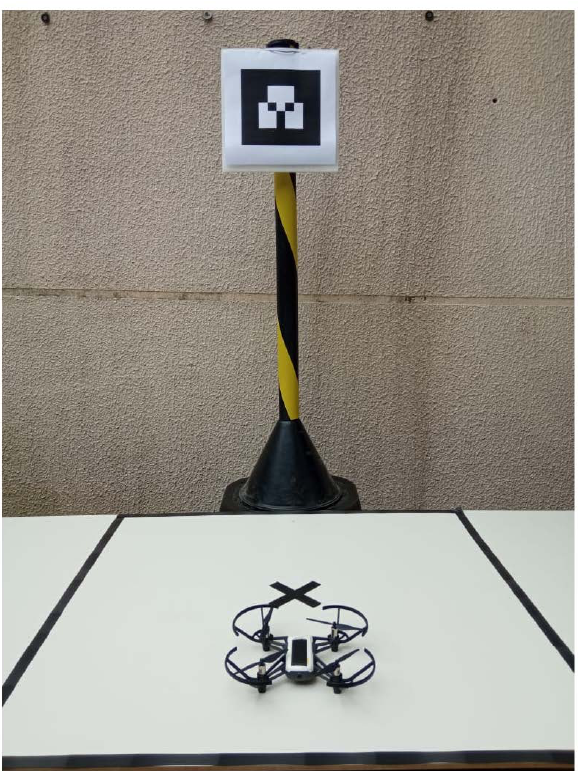
Figure 14. Image of the landing base and the AR-tag with the Tello drone moving toward